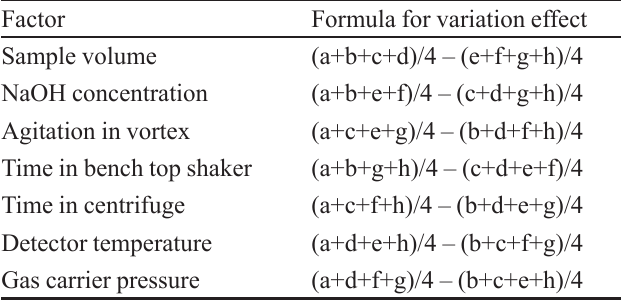
TABLE III - Variation effects evaluation Factor Formula for variation effect